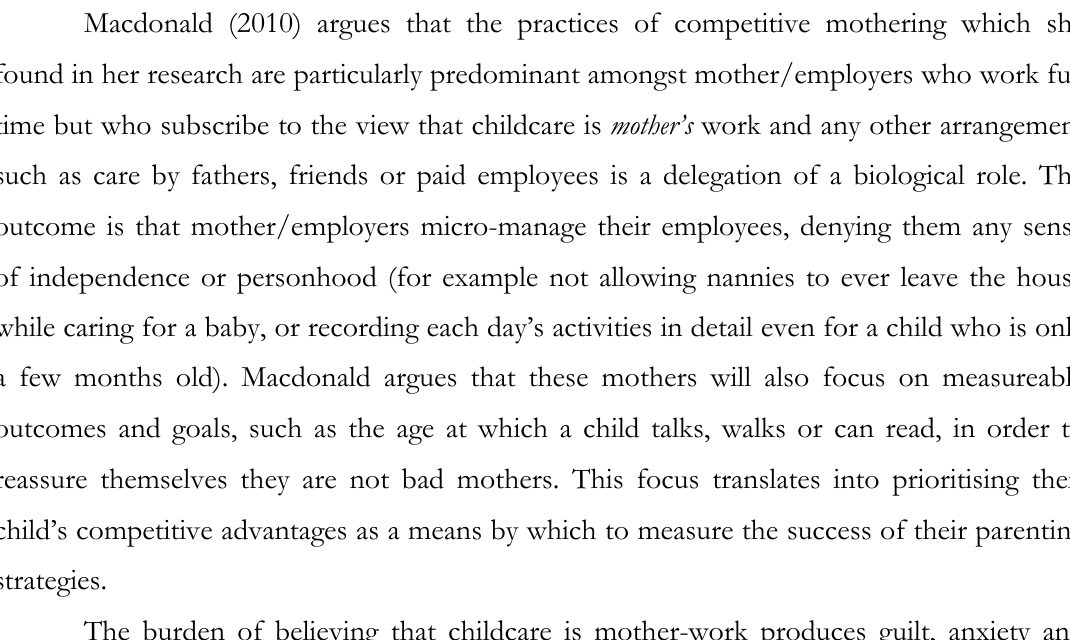
Rosie Cox: Competitive Mothering and Delegated Care: Class Relationships in Nanny and Au Pair